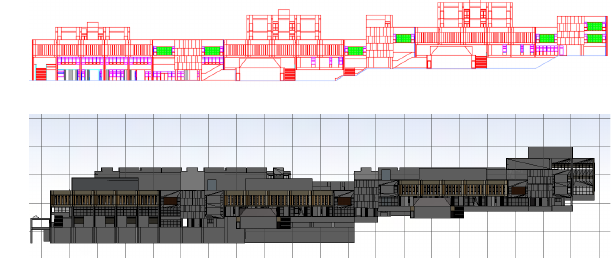
Figure 2. 2D and 3D building